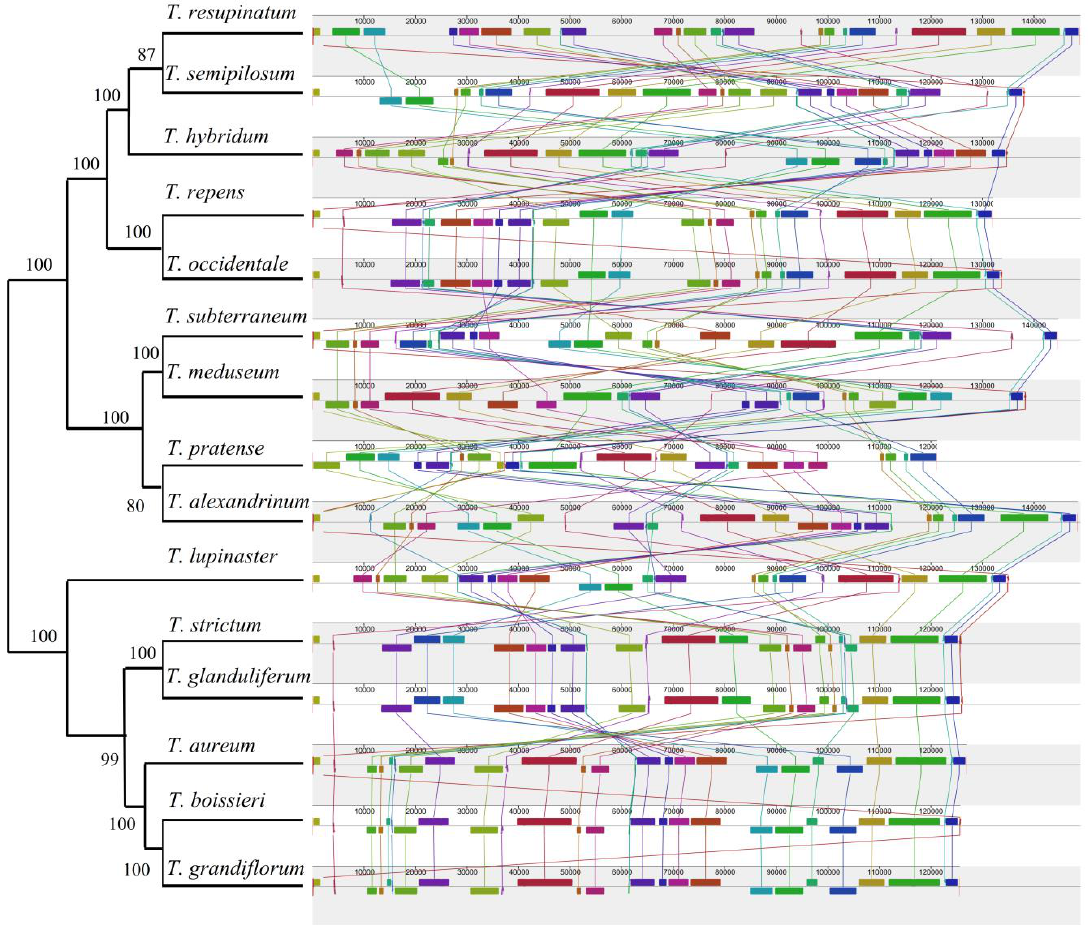
Figure 6. Synteny comparison of fifteen Trifolium chloroplast genomes with the reference of T. resupinatum using Mauve. Rectangular blocks with the same color indicate collinear regions.